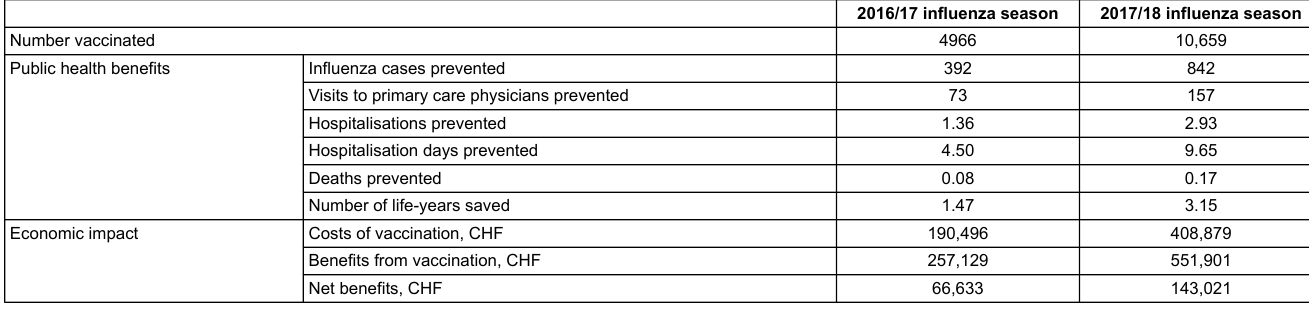
Table 5: Costs and benefits of influenza vaccination in pharmacies in the 2016/17 and 2017/18 seasons for the 19‒65 age